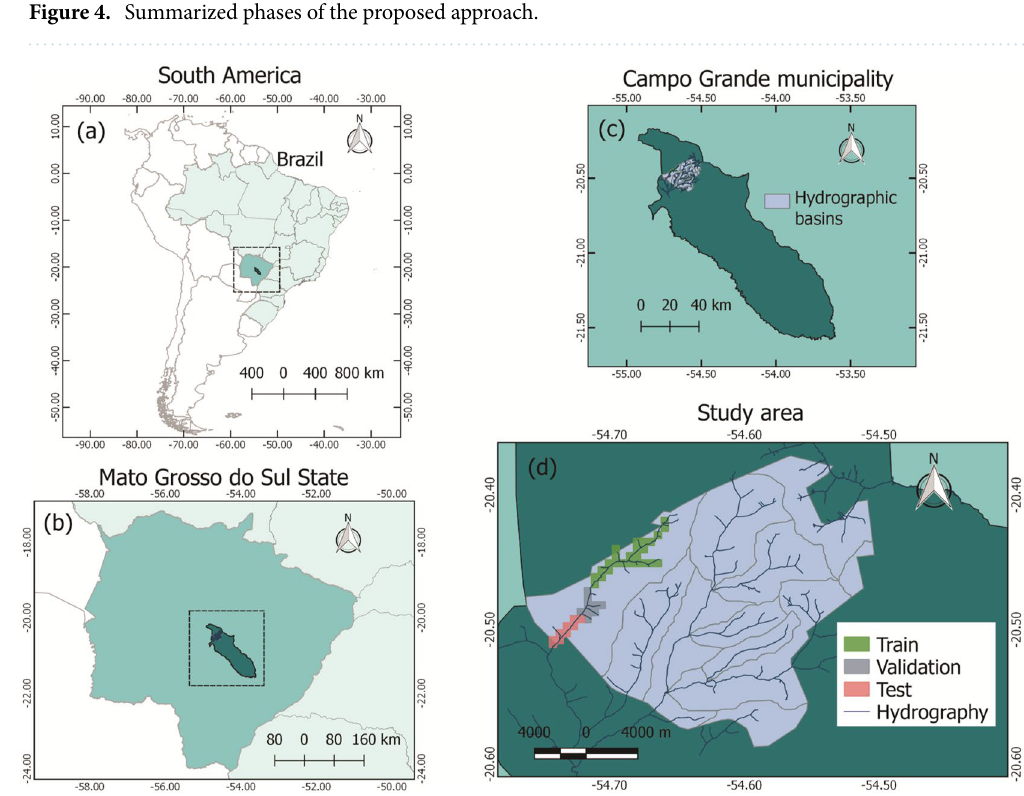
Figure 5. Location map of the study area in ( a ) South America and Brazil, ( b ) Mato Grosso do Sul, ( c ) Campo Grande, and ( d ) study area. Map created with QGIS 3.16.9: https:// qgis. org/ en/